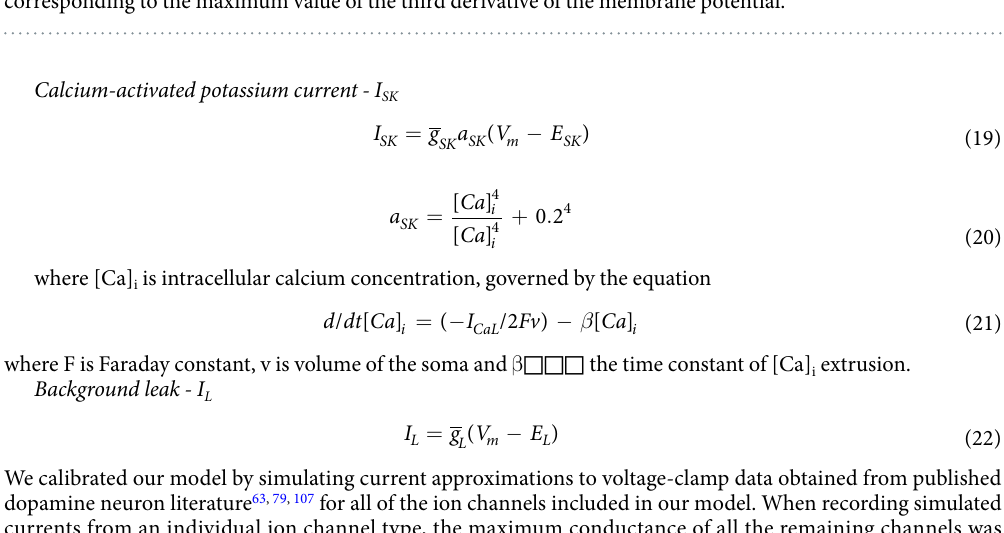
Figure 8. Method for calculation of action potential threshold. Action potential is calculated as the voltage corresponding to the maximum value of the third derivative of the membrane